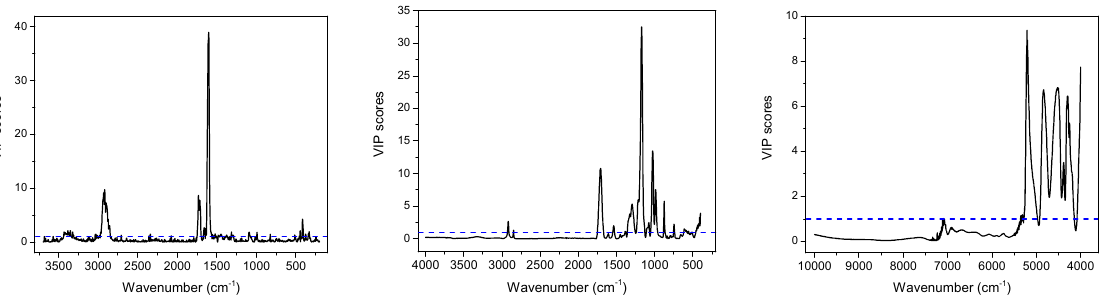
Figure 4. Variable importance in projection (VIP) scores of PLS models for TF obtained on the basis of Raman ( left ), MIR ( middle ) and NIR ( right ) spectra of C. incanus .